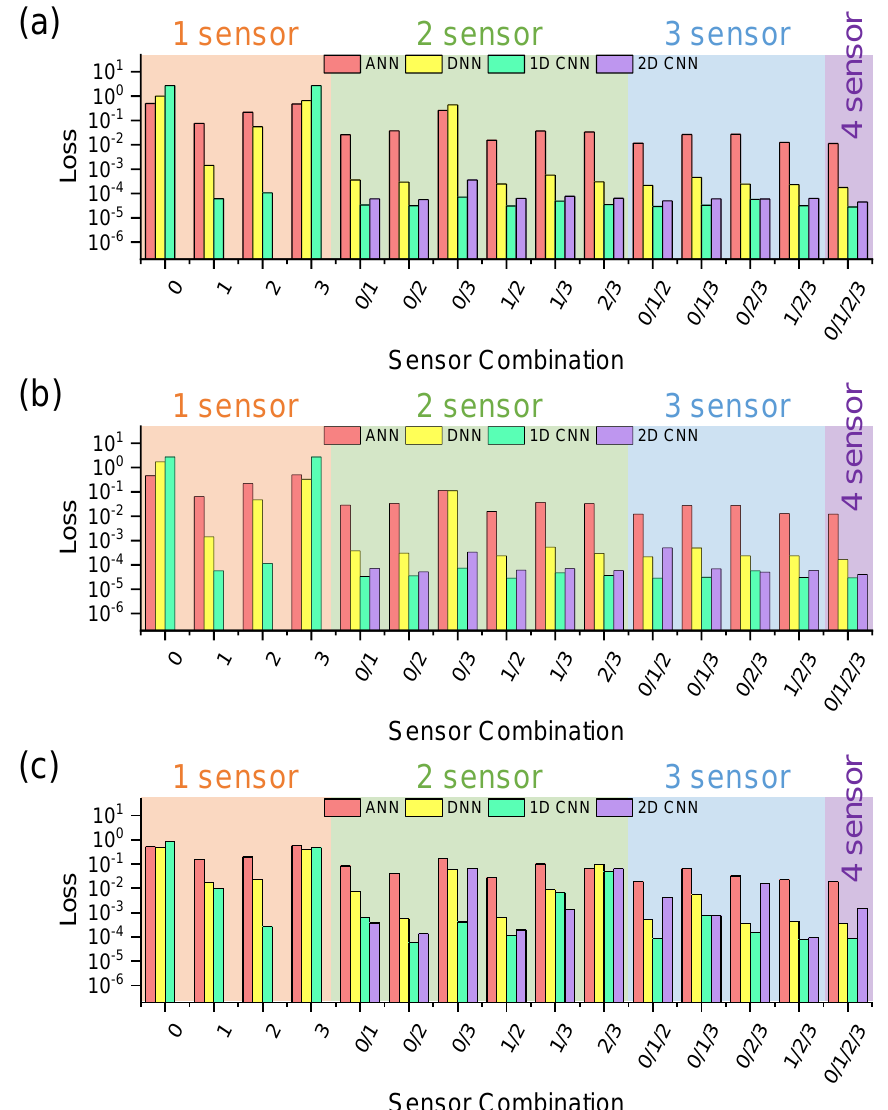
Figure 7. Summarized comparison of neural network–based prediction performances for evaluating the applicability of deep learning algorithms for gas detection/classification in terms of various sensor combinations and machine learning algorithms. ( a ) loss information at training phases, ( b ) loss information at validation phases, and ( c ) loss information at test phases. (The loss evaluations were assessed as a function of the algorithms (ANN, DNN, 1D CNN, and 2D CNN) and the number of sensors, ranging from 4 single sensors to 4-array sensor configurations, with the total of 15 labeled